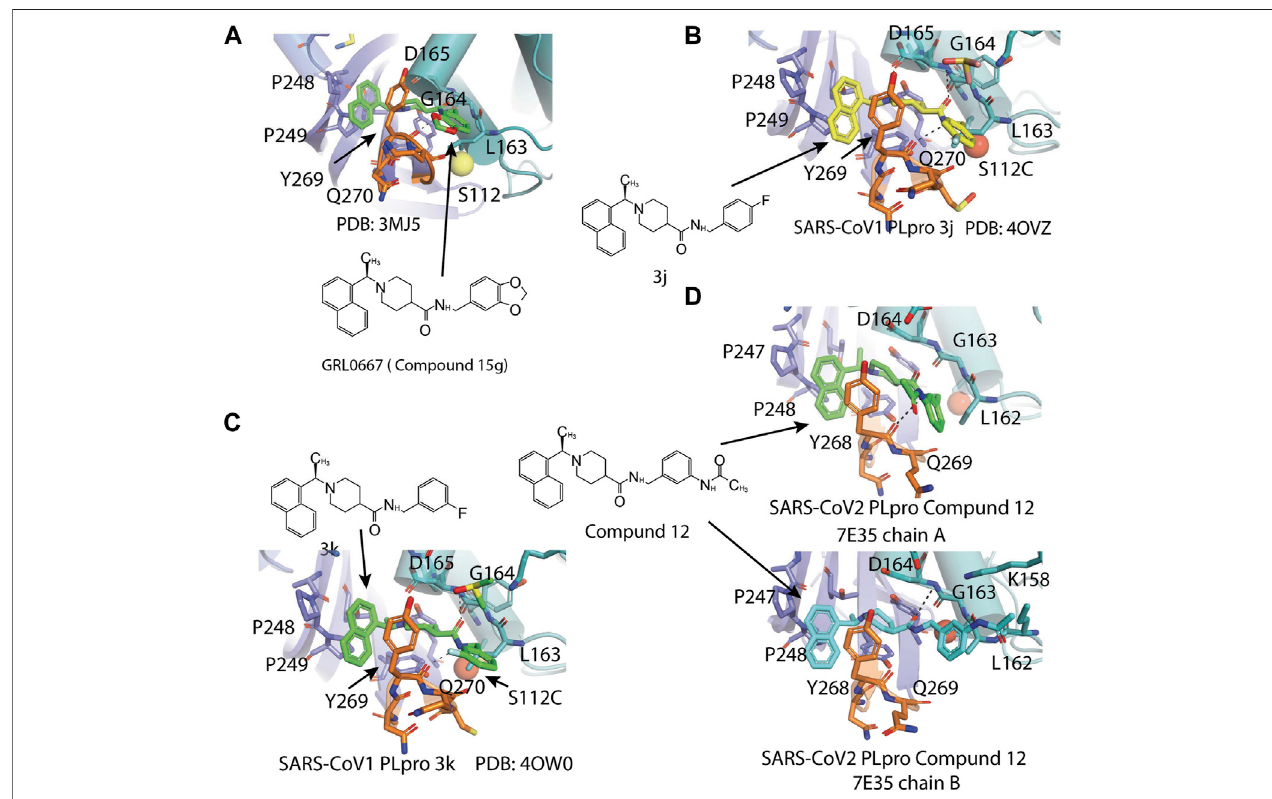
FIGURE 6 | Close-up view of interaction between SARS-CoV-1 PLpro and inhibitors in crystal structures. PLpro is shown as cartoon with sticks representation shown for residues involving contact with inhibitors. Inhibitors are shown as sticks. Hydrogen bonds were labeled with dashed lines. (A) SARS-CoV-1 PLpro with GRL0667 (PDB: 3MJ5). (B) SARS-CoV-1PLprowith3j (PDB:4OVZ). (C) SARS-CoV PLpro with 3k (PDB: 3OW0). (D) SARS-CoV-2 PLpro withcompound 12 from the two copies in the asymmetric unit (PDB: